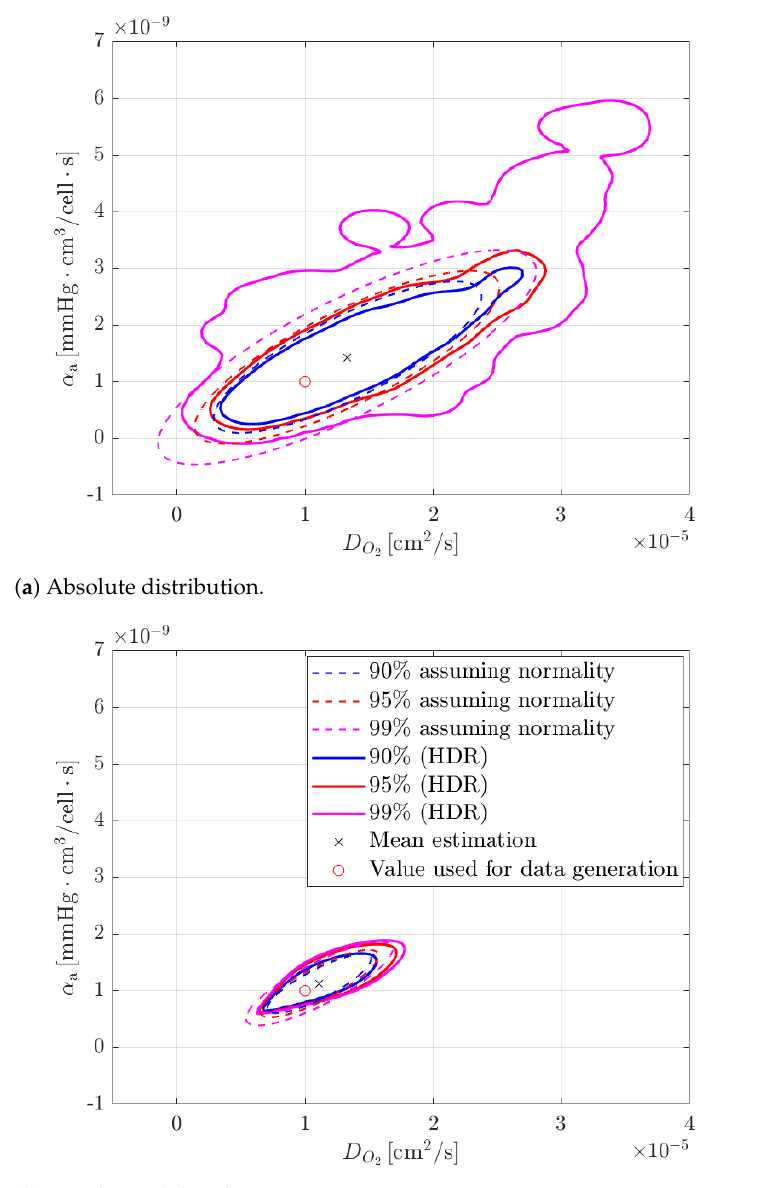
Figure 7. D O – α a point (mean) and region (HDR) 2